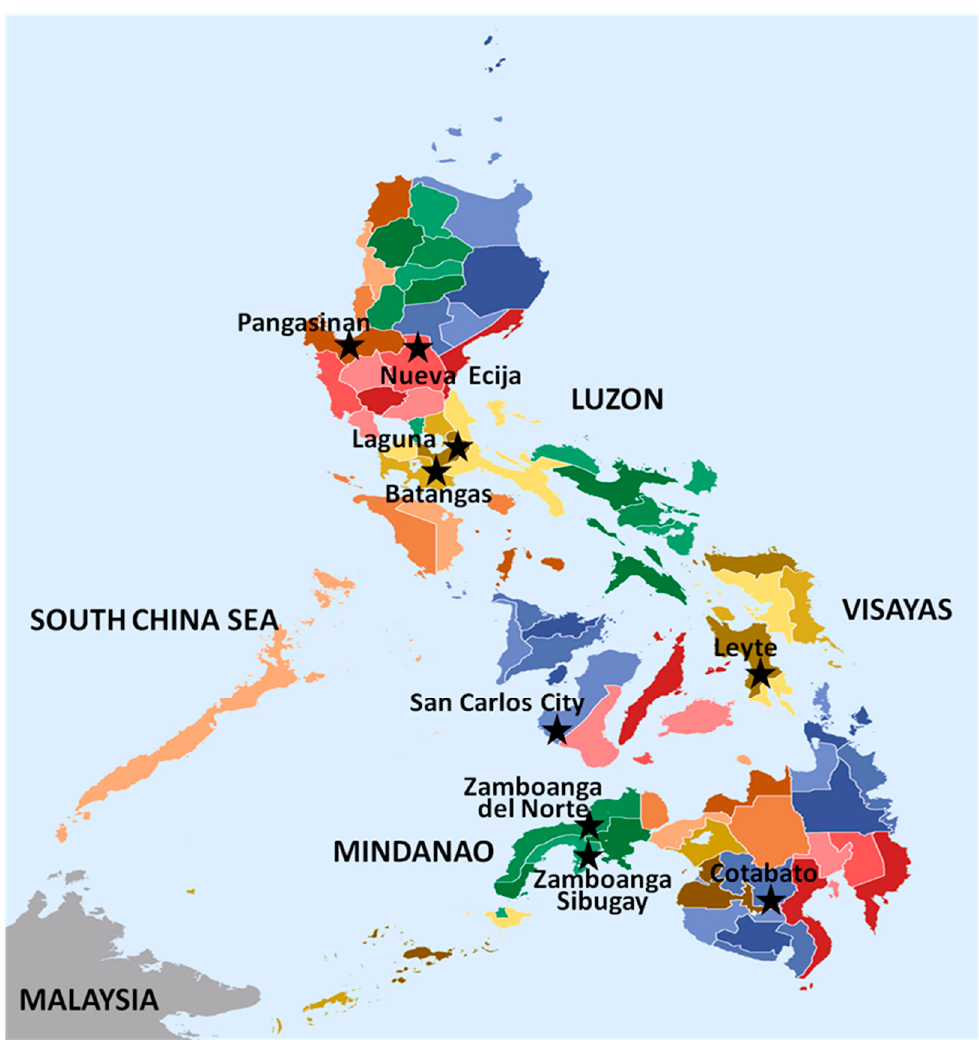
Figure 1. A map of the Philippines showing sampling locations of Magnaporthe oryzae isolates from various rice growing areas. Actual locations are named and indicated with a 5-point star shape.